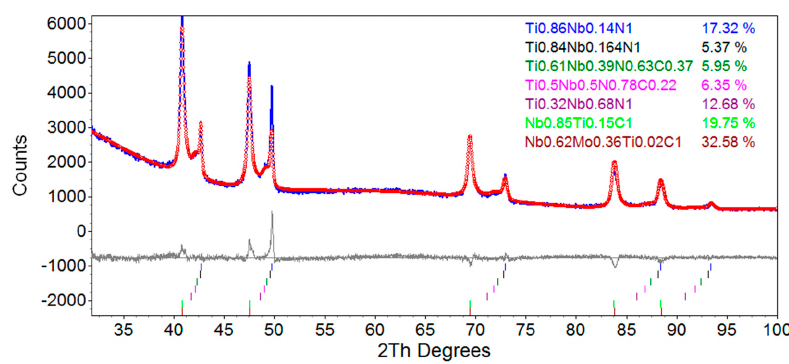
Figure 9. Comparison between measured and predicted diffraction patterns for X70 steel.